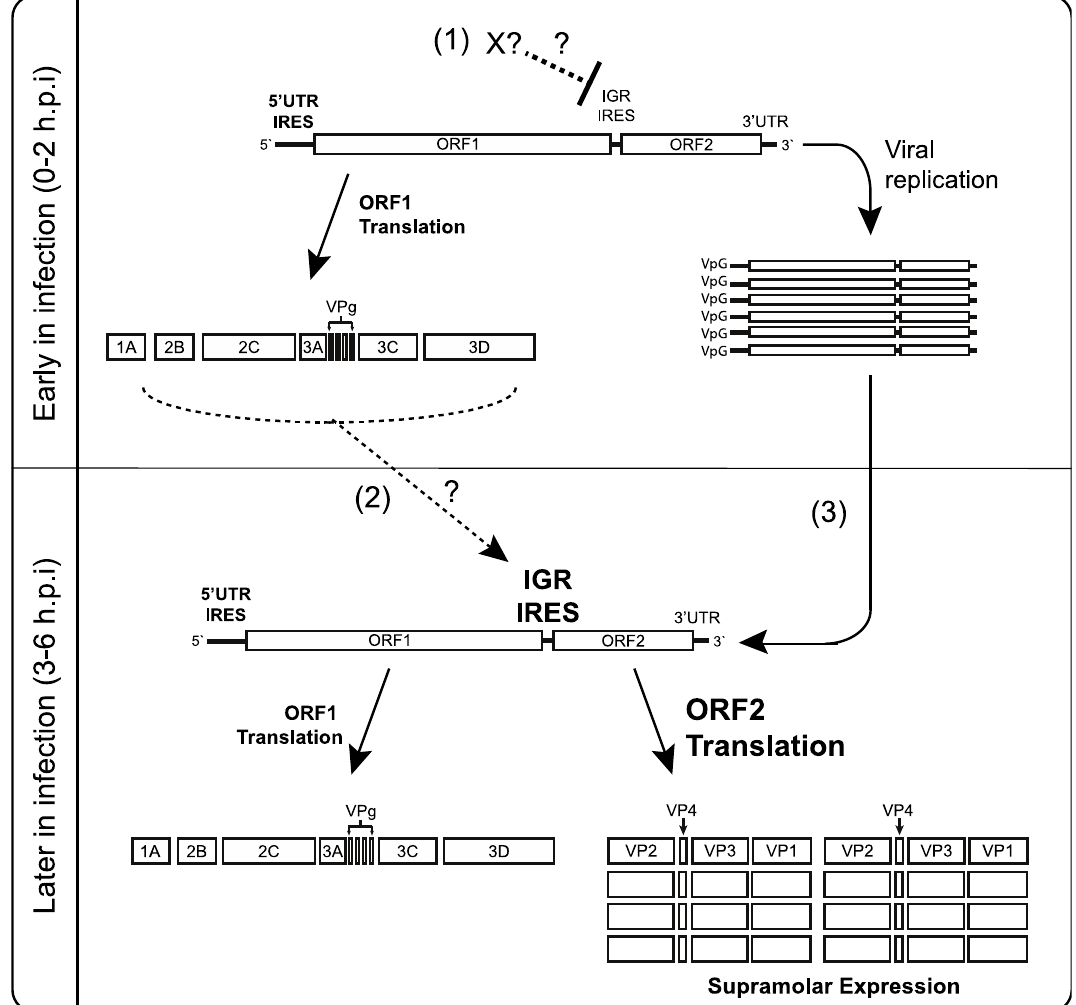
Figure 8. Model of CrPV 5'UTR IRES and IGR IRES-dependent translation during infection. Early in infection (0–2 hpi), 5'UTR IRES-dependent translation predominates to produce viral non-structural infection (0–2 hpi), 5 1 UTR IRES-dependent translation predominates to produce viral proteins such as the 3D RNA-dependent RNA polymerase, the 3C-like protease and helicase. (1) IGR IRES translation may be inhibited directly or indirectly by a yet unknown factor; (2) At 3–4 hpi, non-structural viral proteins may directly or indirectly stimulate IGR IRES translation (dashed arrow), leading to viral structural protein expression; (3) Replication of the viral genome enhances structural protein expression by providing more translatable CrPV genomes and/or stimulating IGR IRES activity. In effect, the temporal regulation of viral protein synthesis via IRES control allows viral replication to occur prior to structural protein synthesis.